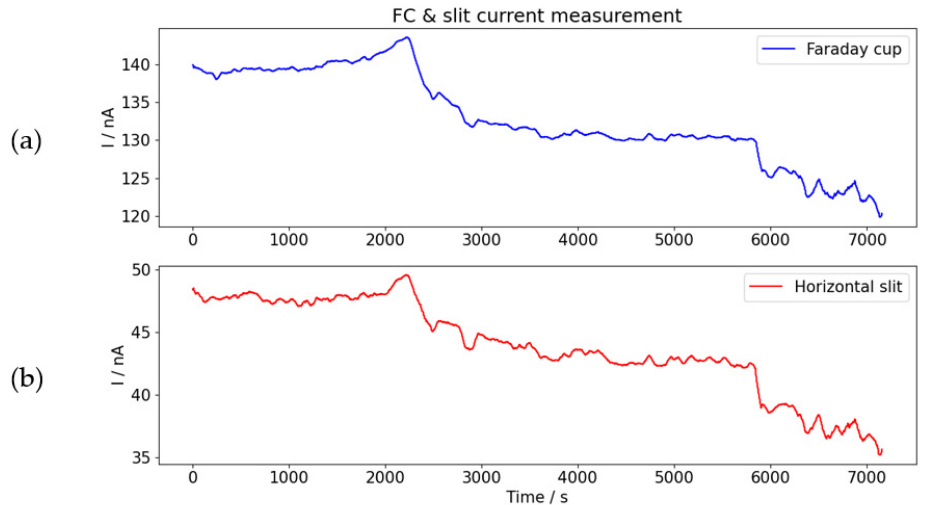
Figure 10. Comparison of ion current readings from Faraday cup ( a ) with ion current reading from slits ( b ).